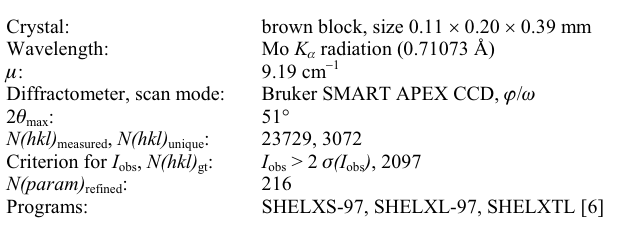
Table 1. Data collection and handling.